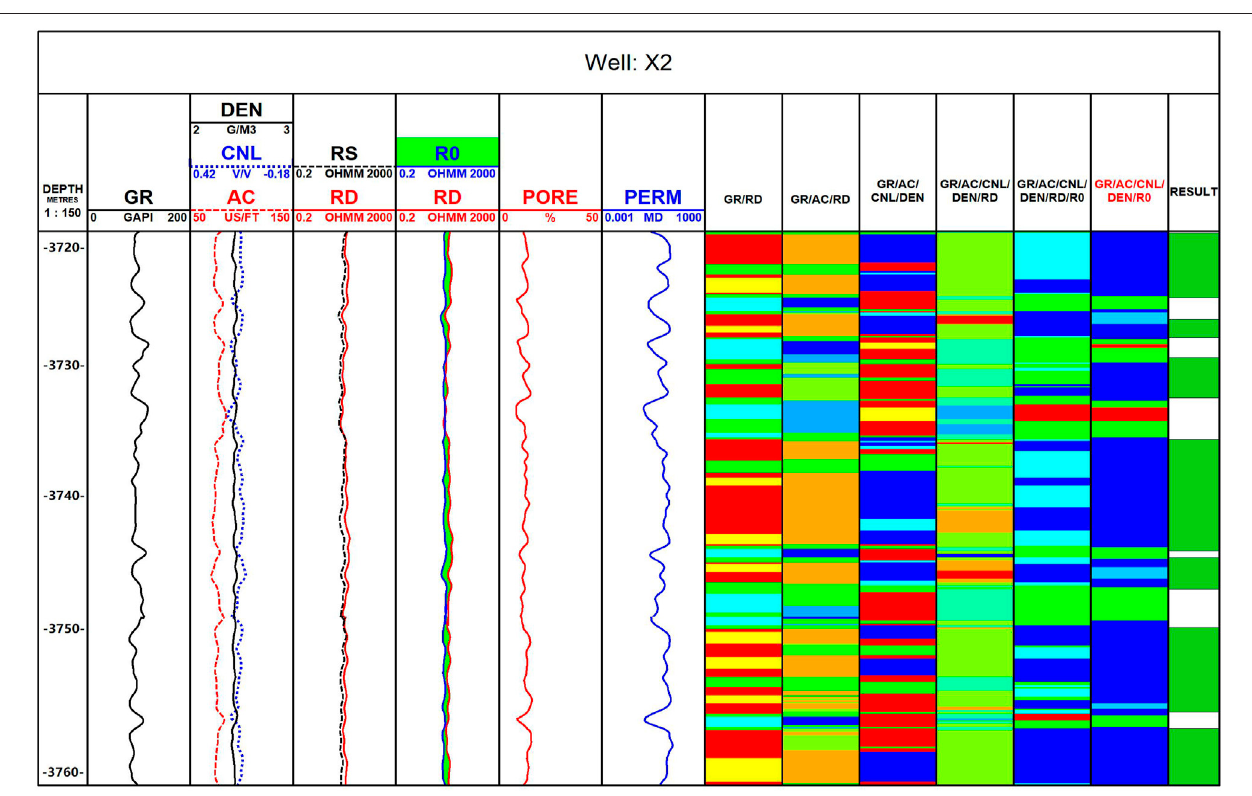
FIGURE 7 | Comparison of automatic clustering division of logging facies with different parameter combinations.